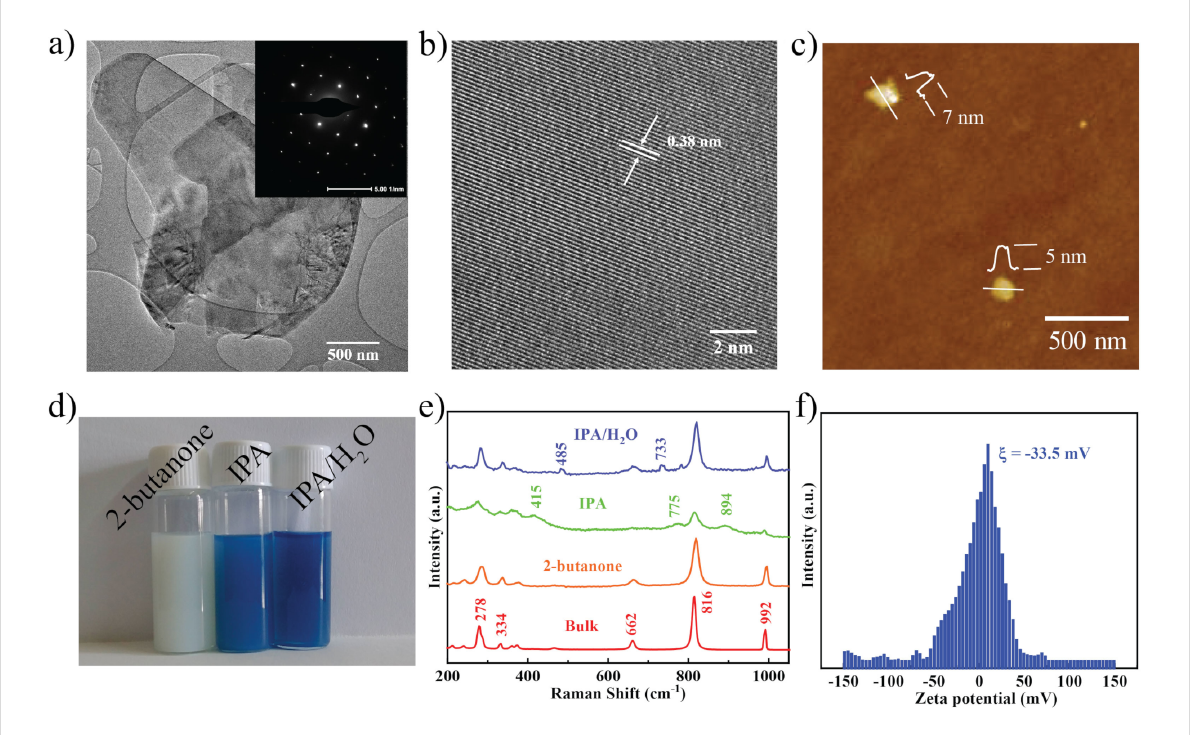
Figure 2: (a) TEM micrograph of MoO 3 nanosheets. The inset shows the SAED pattern; (b) HRTEM micrograph of MoO 3 nanosheets; (c) AFM micro- graph of MoO 3 nanosheets; (d) photograph of MoO 3 dispersions in 2-butanone, IPA and IPA/H 2 O mixture; (e) Raman spectra of bulk and exfoliated MoO 3 in different solvents; (f) zeta potential of MoO 3 dispersions in